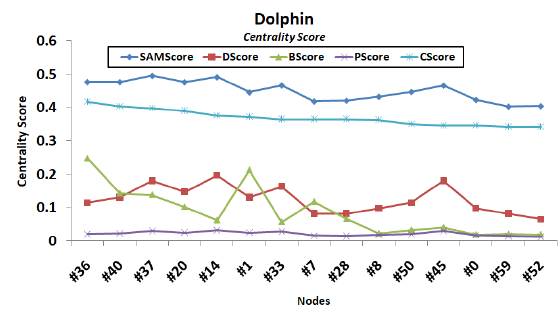
Figure 7. Centrality score of top 15 nodes from Dolphin dataset, sorted by SAM centrality